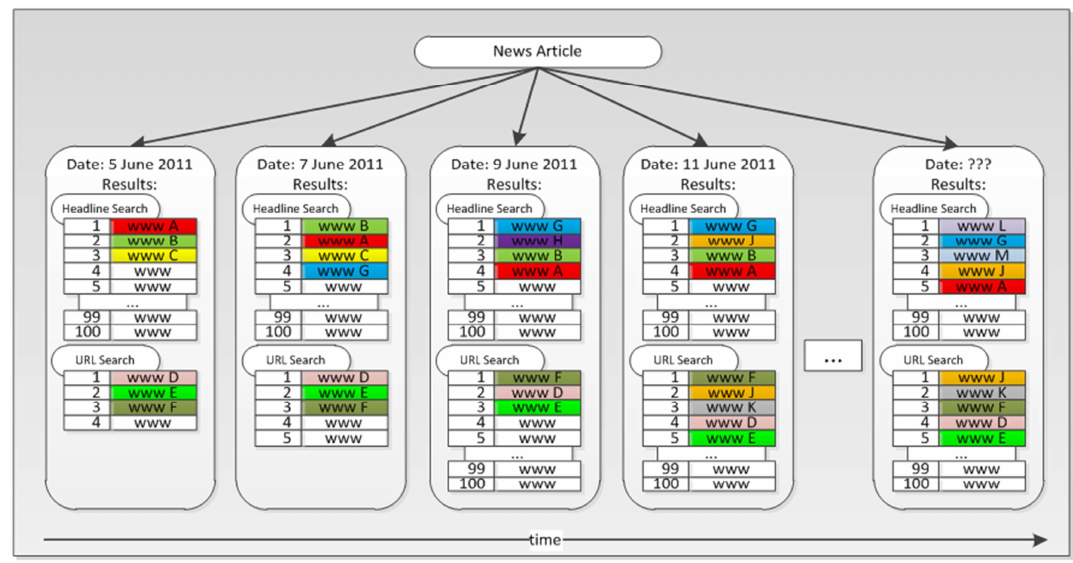
Figure 2: Example News Article, Associated Searches &